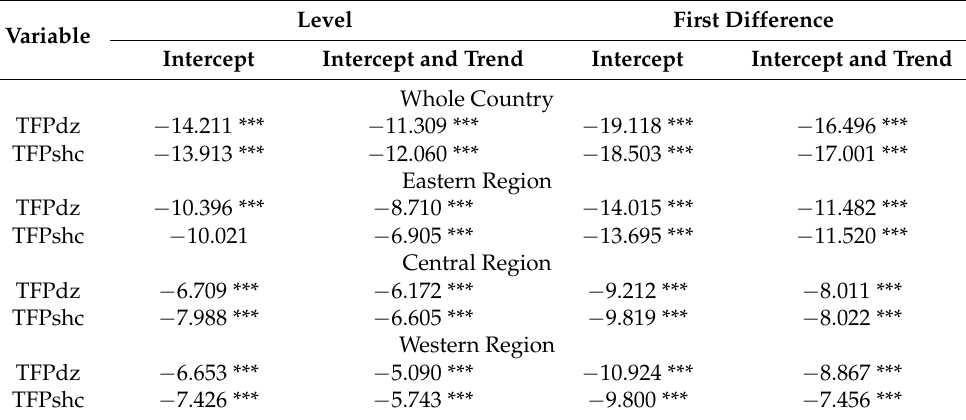
Table 3. The results of the ADF panel unit root